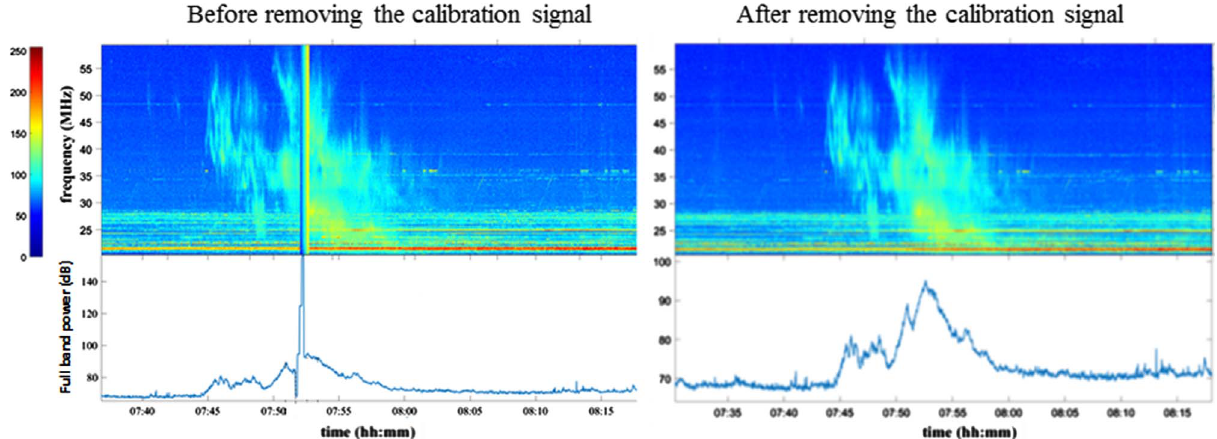
Fig. 5. Example of removing the calibration signal by the method described in Section 4.1. Top panels: dynamic spectra. Bottom panels: time histories integrated over the entire frequency